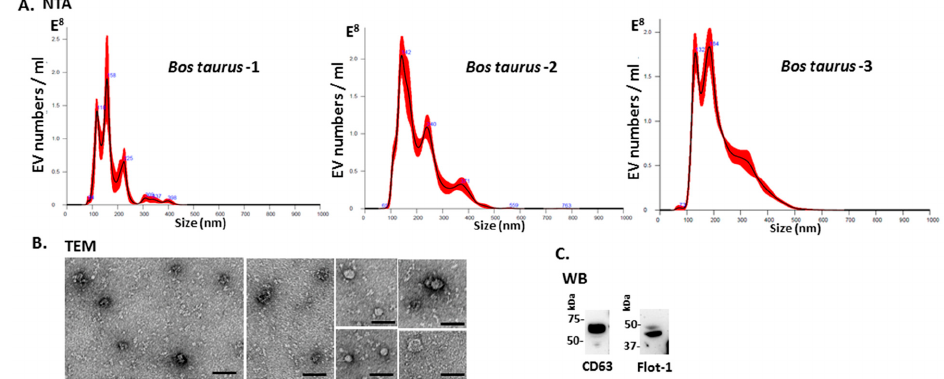
Figure 1. Extracellular vesicle profiling in bovine serum. ( A ) Nanoparticle tracking analysis shows a size distribution of plasma-EVs from Bos taurus in the size range of 70 to 500 nm, with main peaks at approximately 120–240 nm. ( B ) Transmission electron microscopy (TEM) analysis of bovine serum-derived EVs shows typical EV morphology; scale bar is 50 nm in all figures. ( C ) Western blotting analysis confirms that bovine EVs are positive for the phylogenetically conserved EV-specific markers CD63 and Flot-1, showing positive at expected molecular weight size corresponding to what is observed in other taxa (kDa =